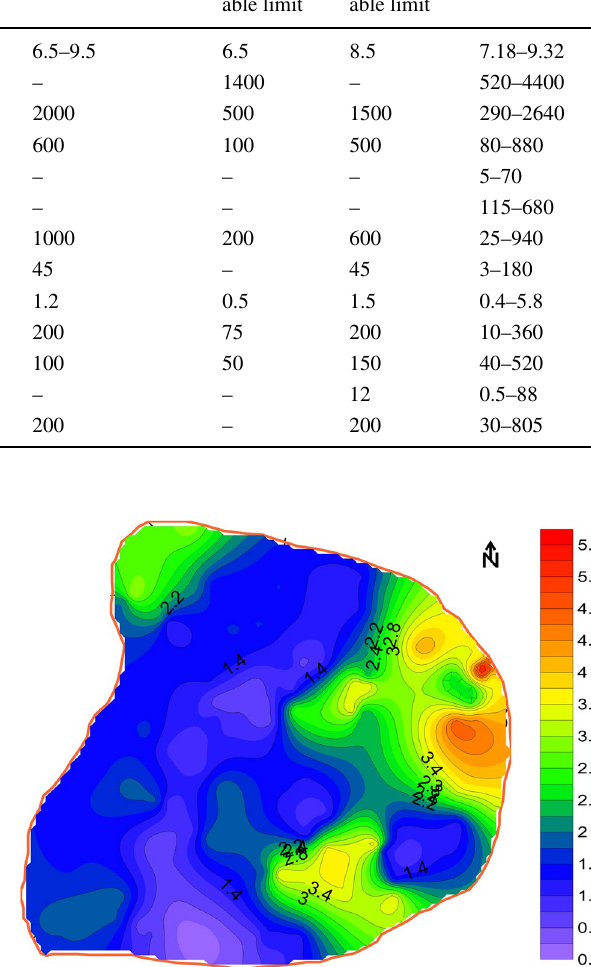
from a rural part of Andhra Pradesh, India exceeding the permissible limits prescribed by WHO (2004) and ISI (1993) for drinking purpose